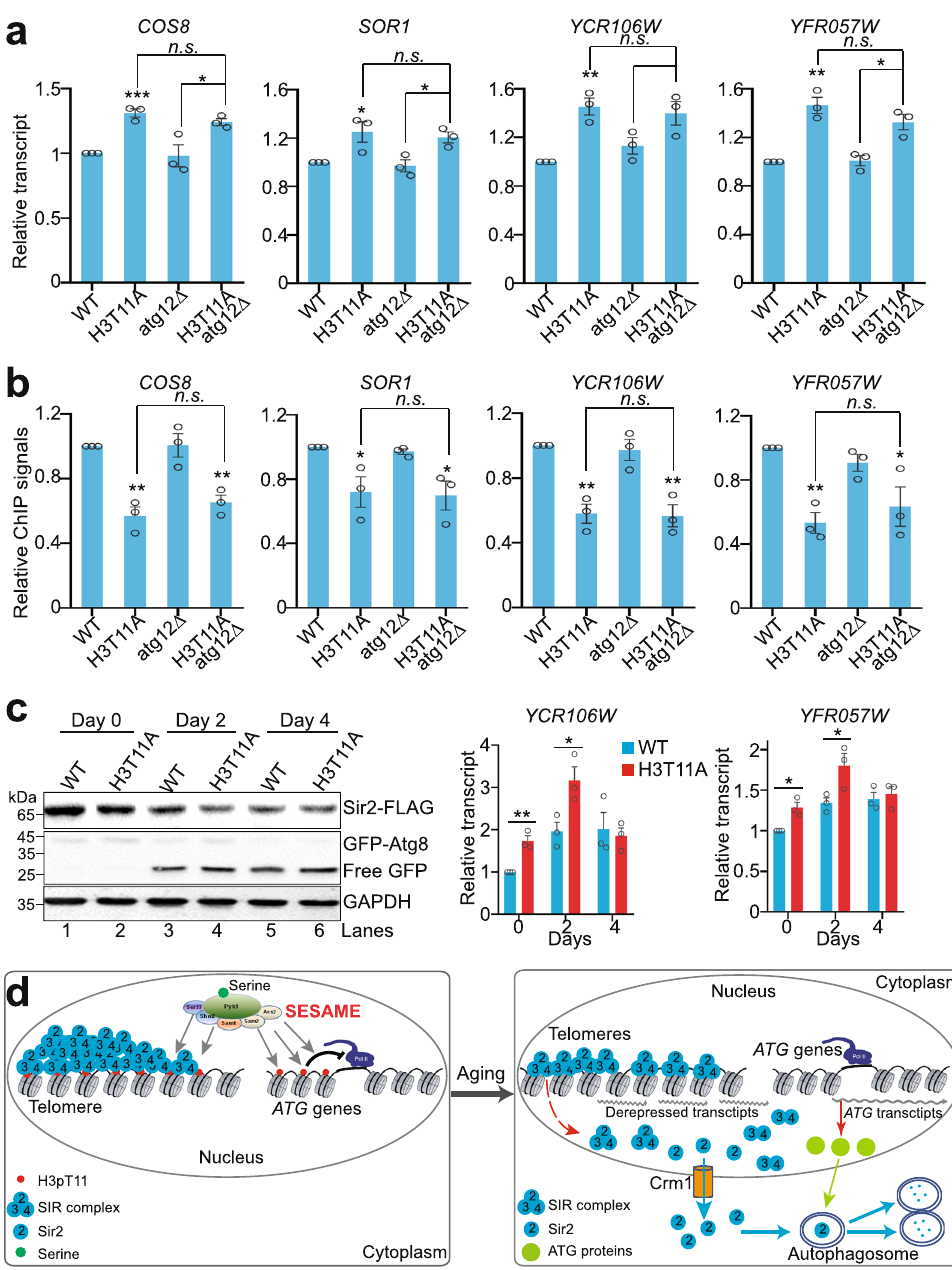
Fig. 7 H3T11 phosphorylation maintains telomere silencing by promoting Sir2 binding at telomeres and preventing autophagy-mediated Sir2 degradation. a qRT-PCR analysis of COS8 , SOR1 , YCR106W , and YFR057W in WT, H3T11A, atg12 Δ , and H3T11A atg12 Δ mutants. b ChIP-PCR analysis of Sir2 occupancy at COS8 , SOR1 , YCR106W , and YFR057W in WT, H3T11A, atg12 Δ , and H3T11A atg12 Δ mutants. c Left panel: Western blots analysis of Sir2